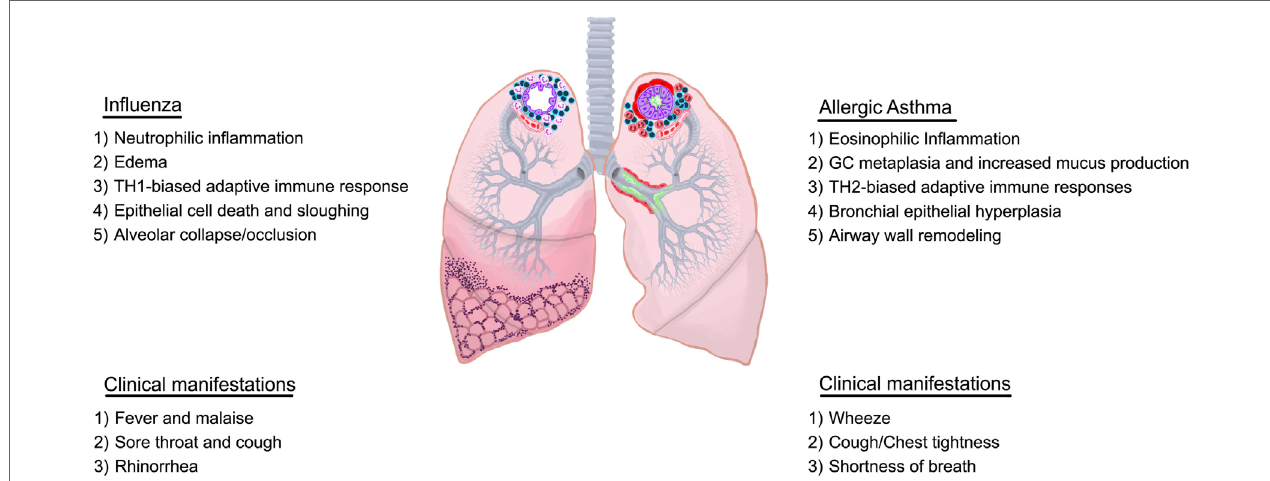
FiGURe 1 | Overview of characteristics of influenza and allergic asthma. Immunological and structural components differ between influenza and allergic asthma although some overlap may exist in the clinical